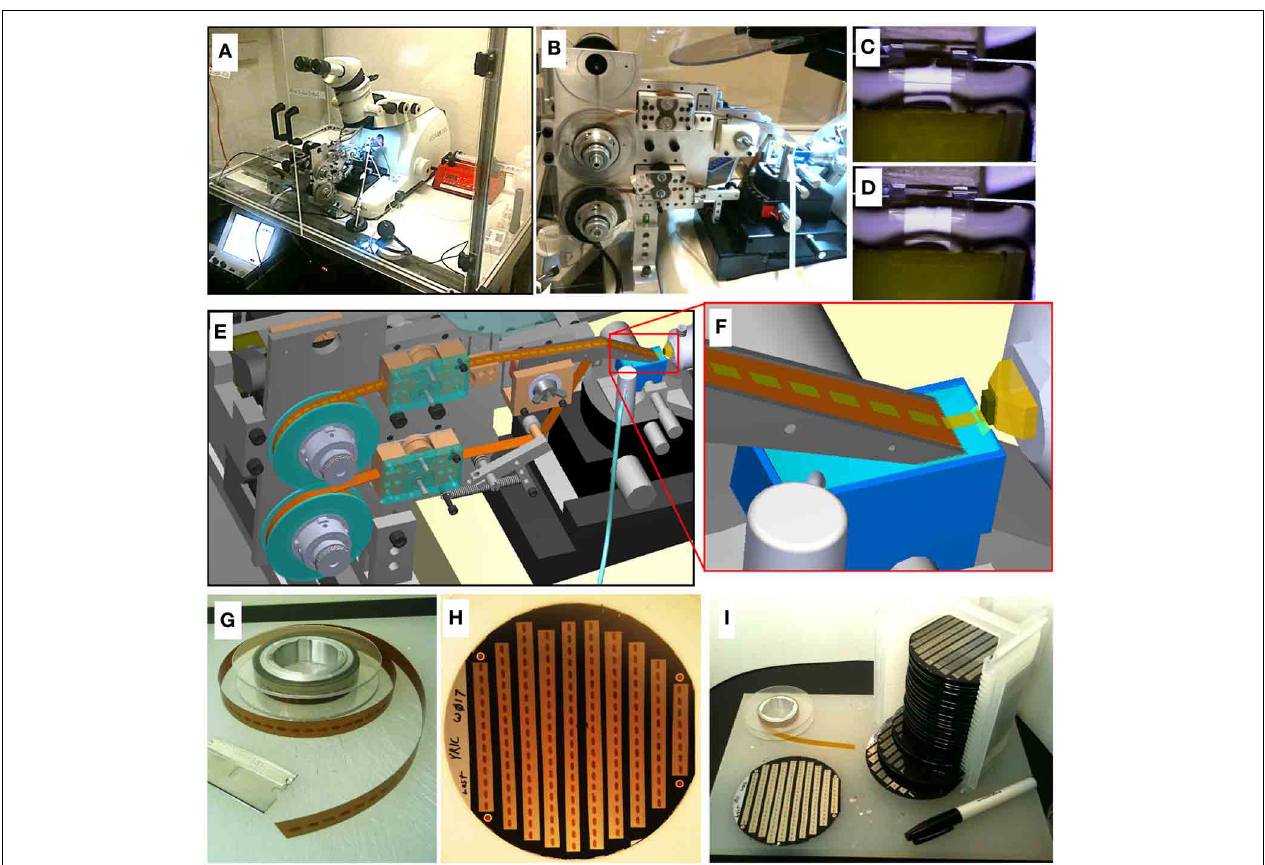
FIGURE 1 | ATUM-SEM process. (A) Picture of ATUM tape collection device installed on a commercial ultramicrotome housed in an environmental control chamber. (B) Side view of ATUM. (C,D) Sequential video images of section collection. (E) CAD rendering of ATUM showing path collected sections take from the knife boat to the final take-up reel. (F) CAD zoom in on knife boat showing collection process. (G) Picture of unraveled tissue-tape on take-up reel containing a series of ultrathin